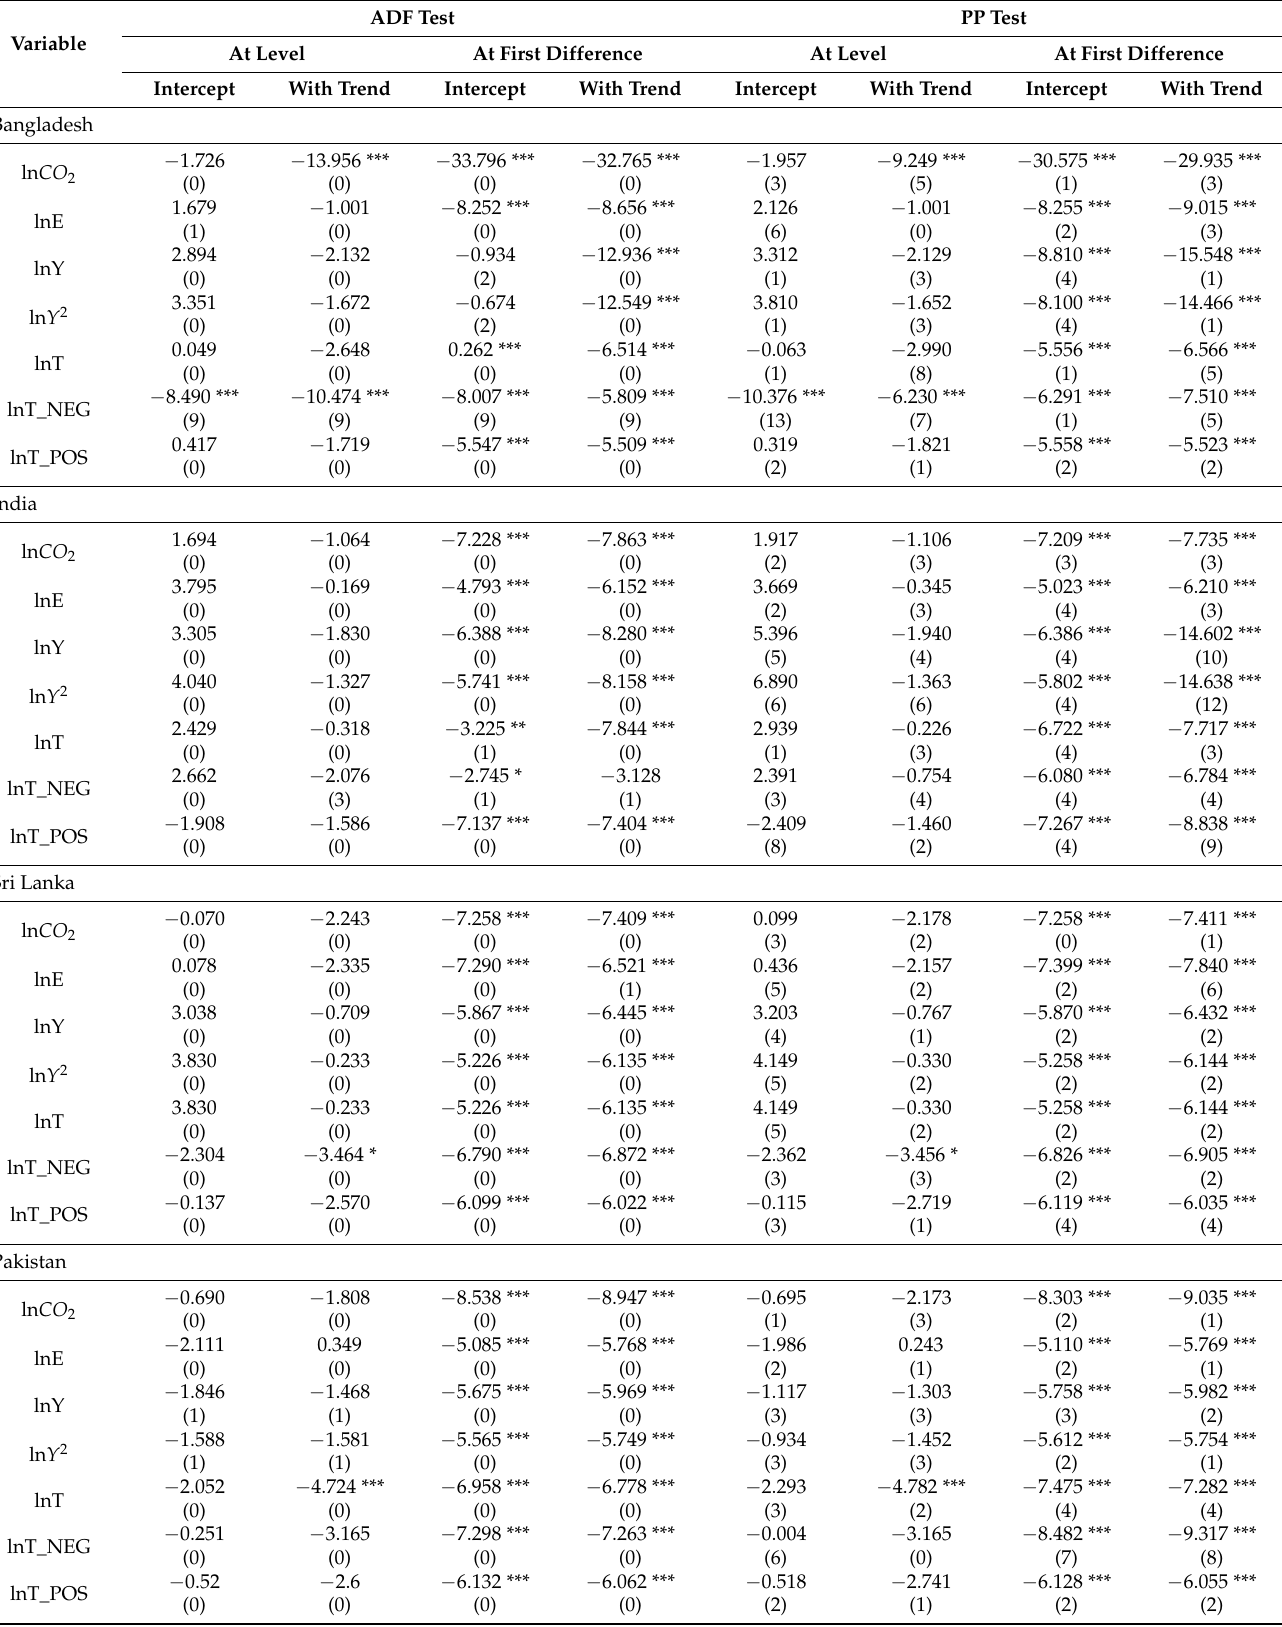
Table A3. ADF and PP unit root tests